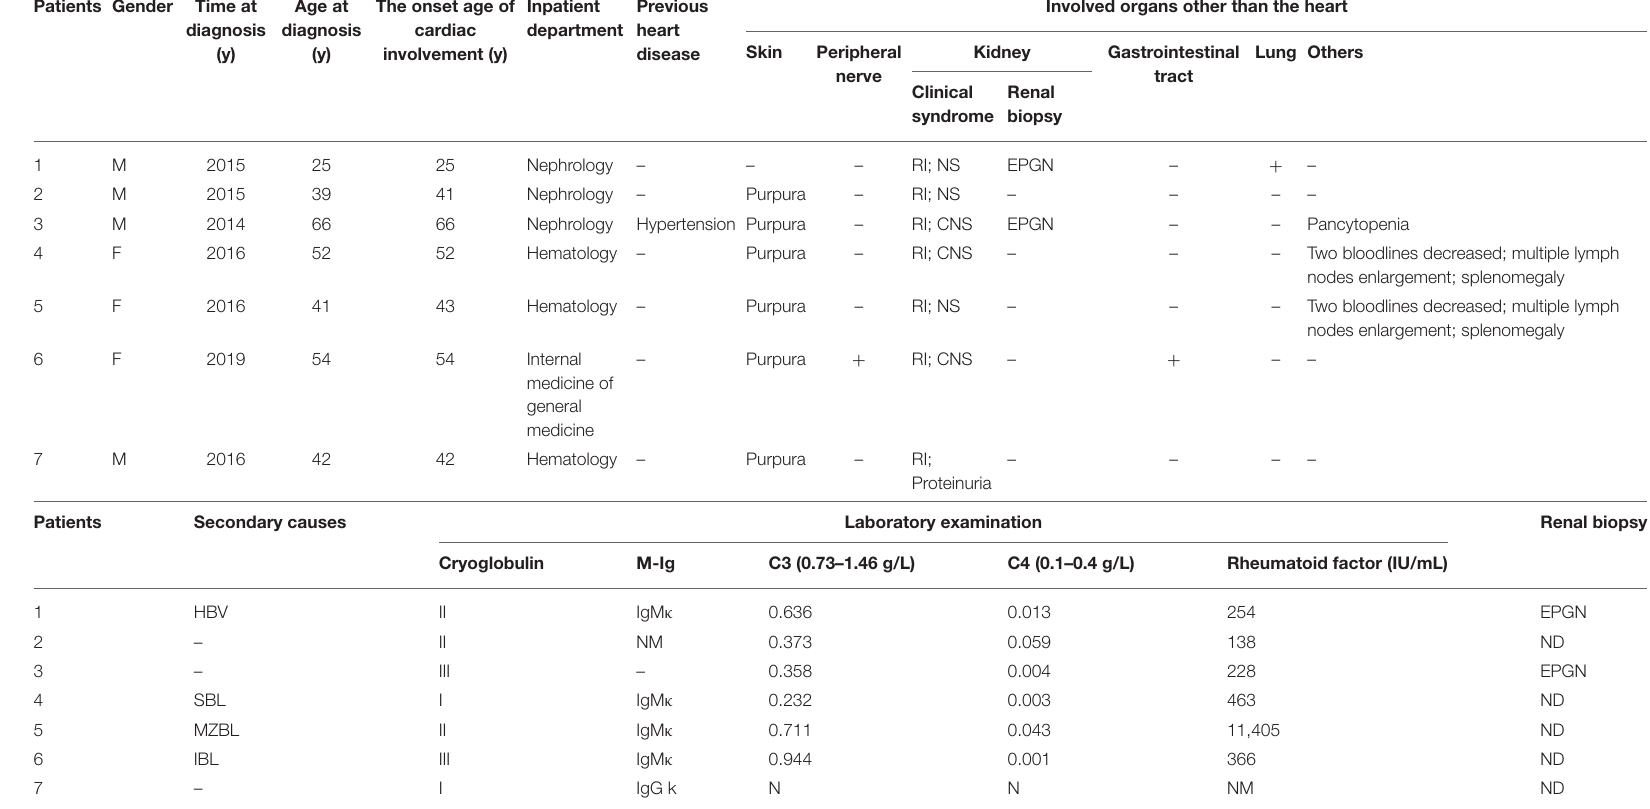
TABLE 1 | General data and clinical features of 7 patients in cryoglobulinemia with cardiac involvement. Patients Gender Time at diagnosis